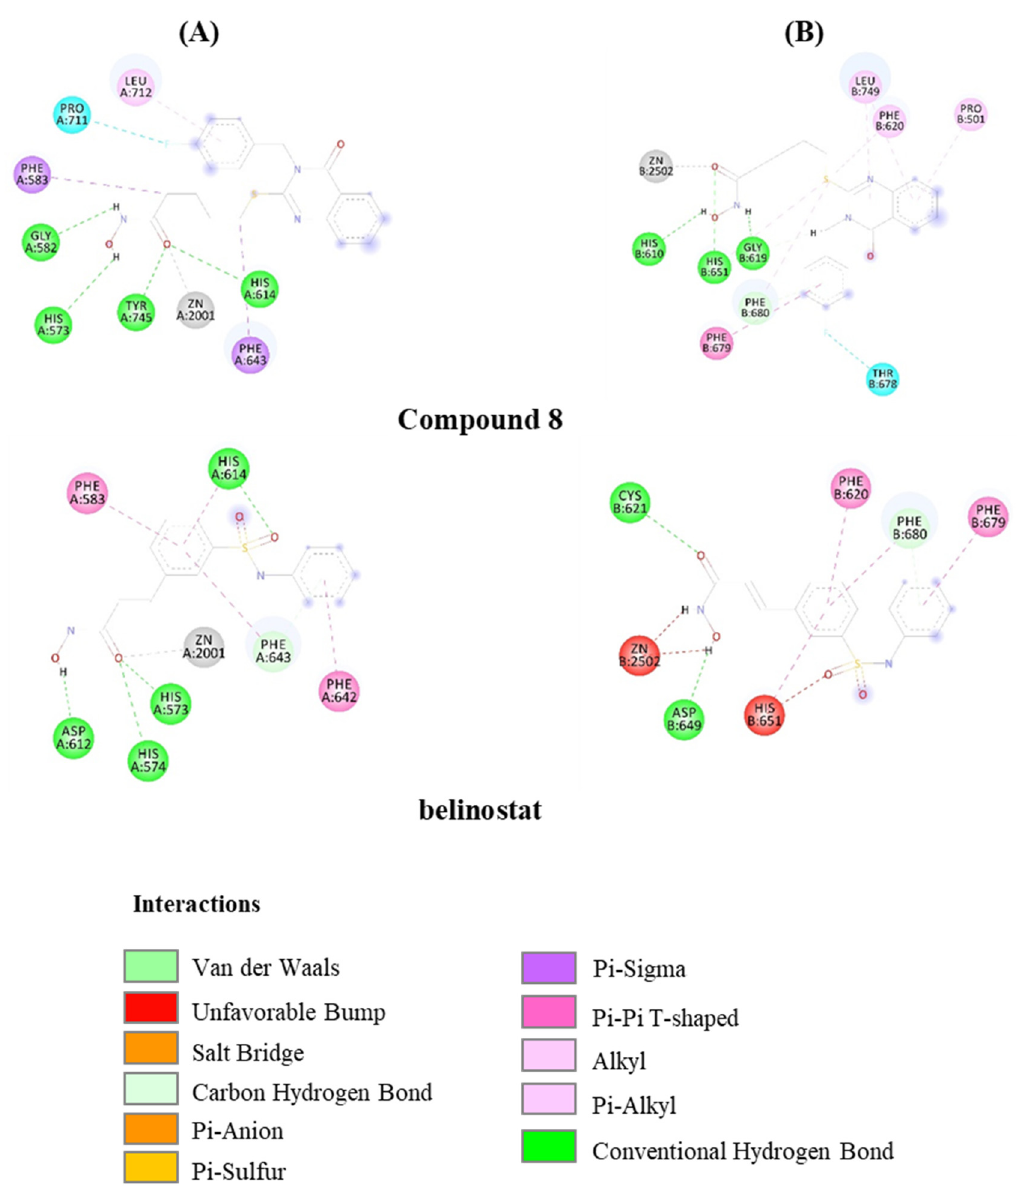
Figure 7. Docking conformation of compound 8 and Belinostat with HDAC enzymes. ( A ) Docking pose of studied ligand with HDAC6; ( B ) docking pose of studied ligand with HDAC11. (Docking images were prepared by using the Discovery Studio Vizualizer version